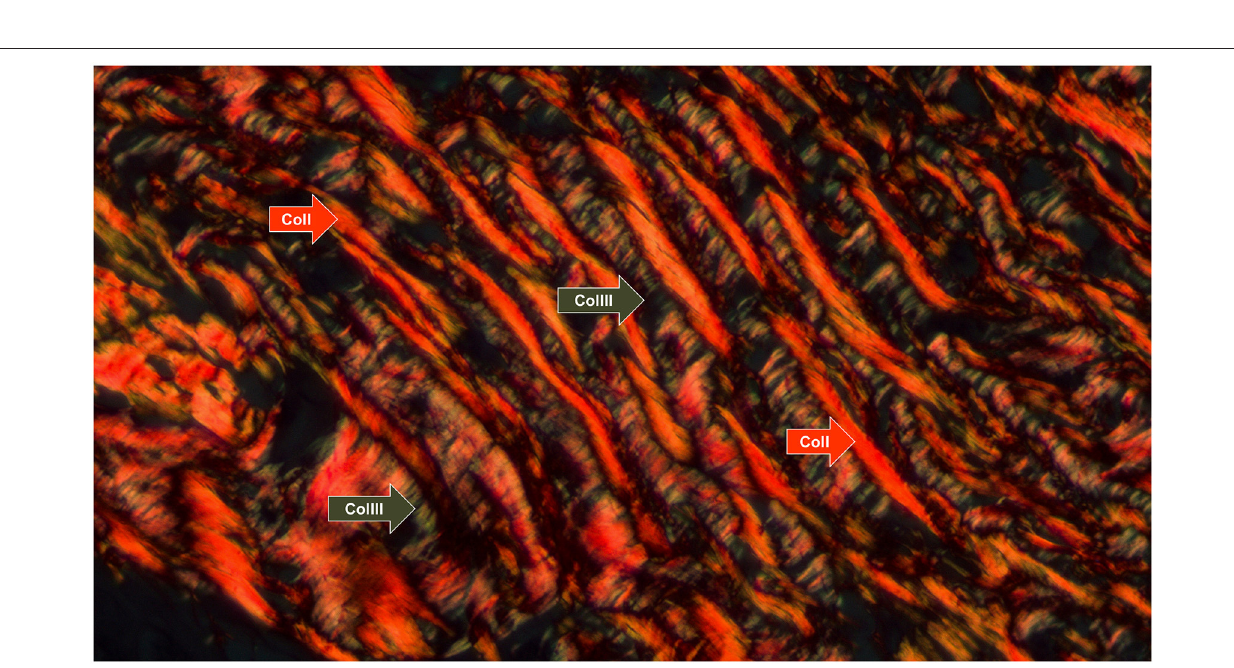
Frontiers in Medicine |